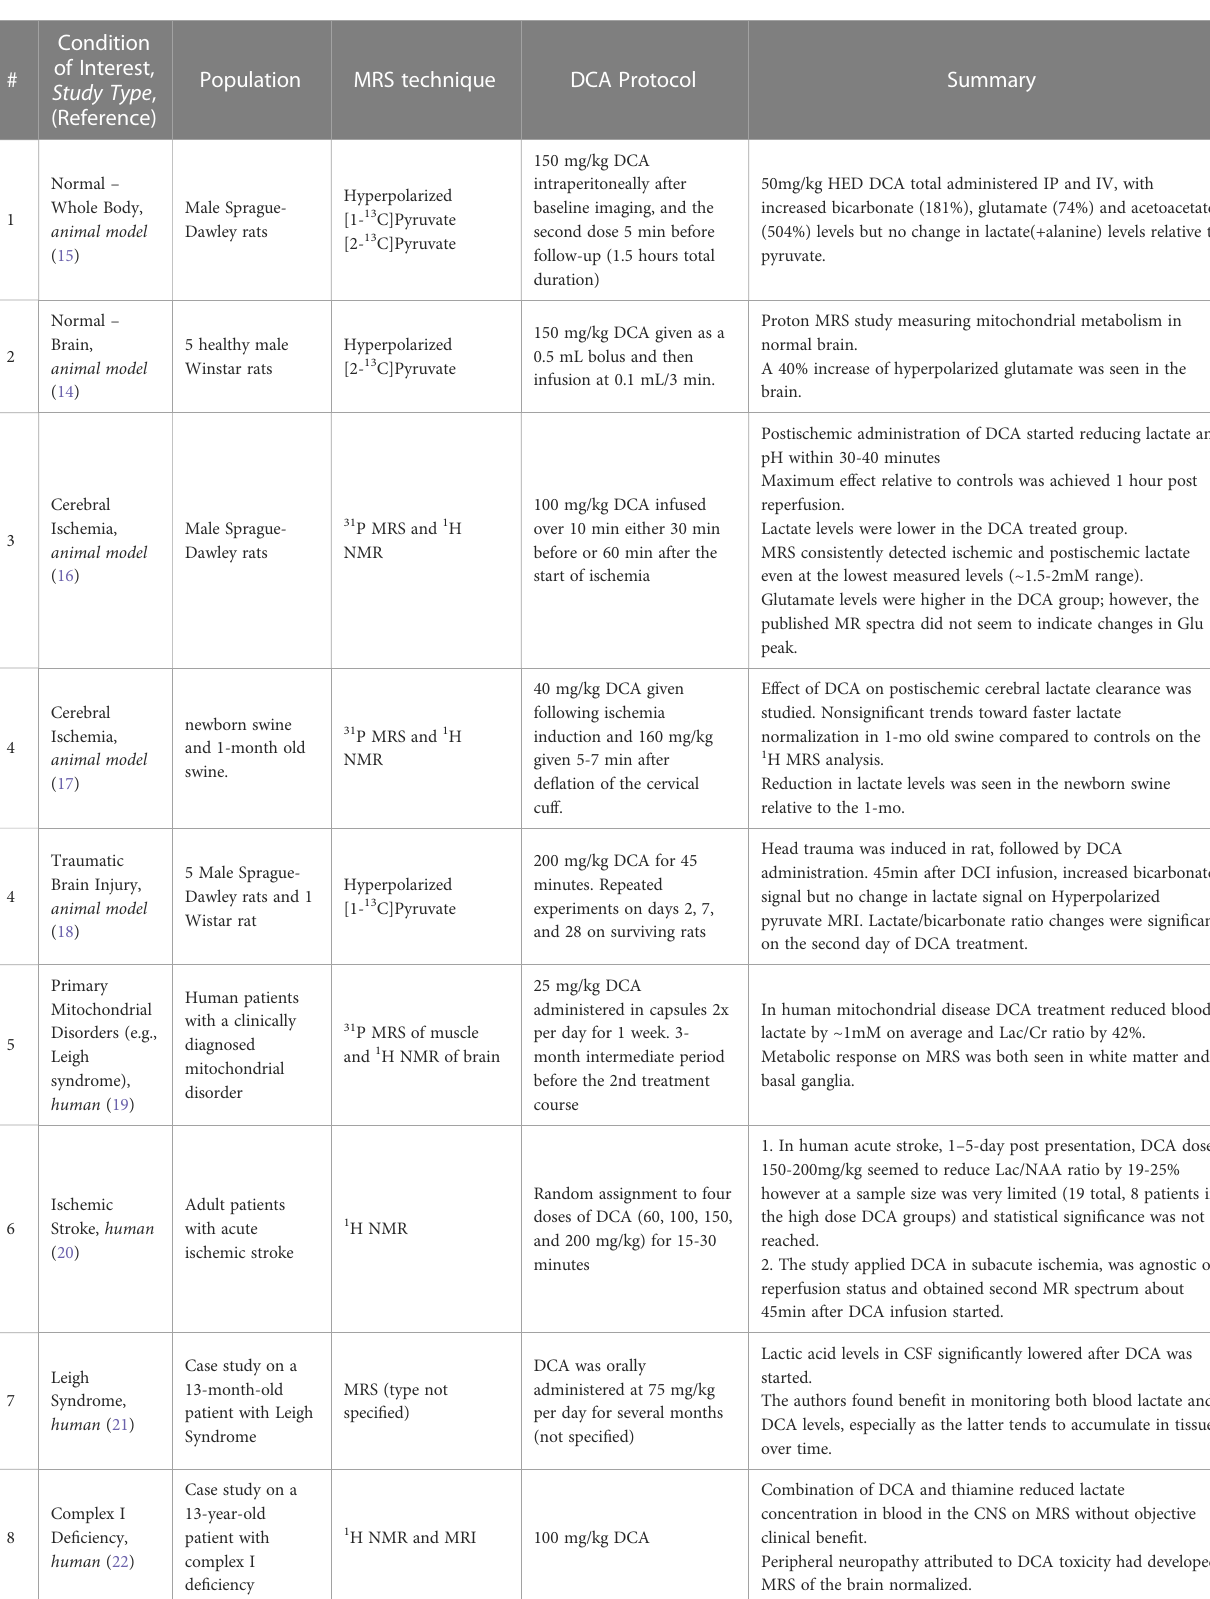
TABLE 1 Metabolic Effects of DCA in Non-Cancerous and Cancerous